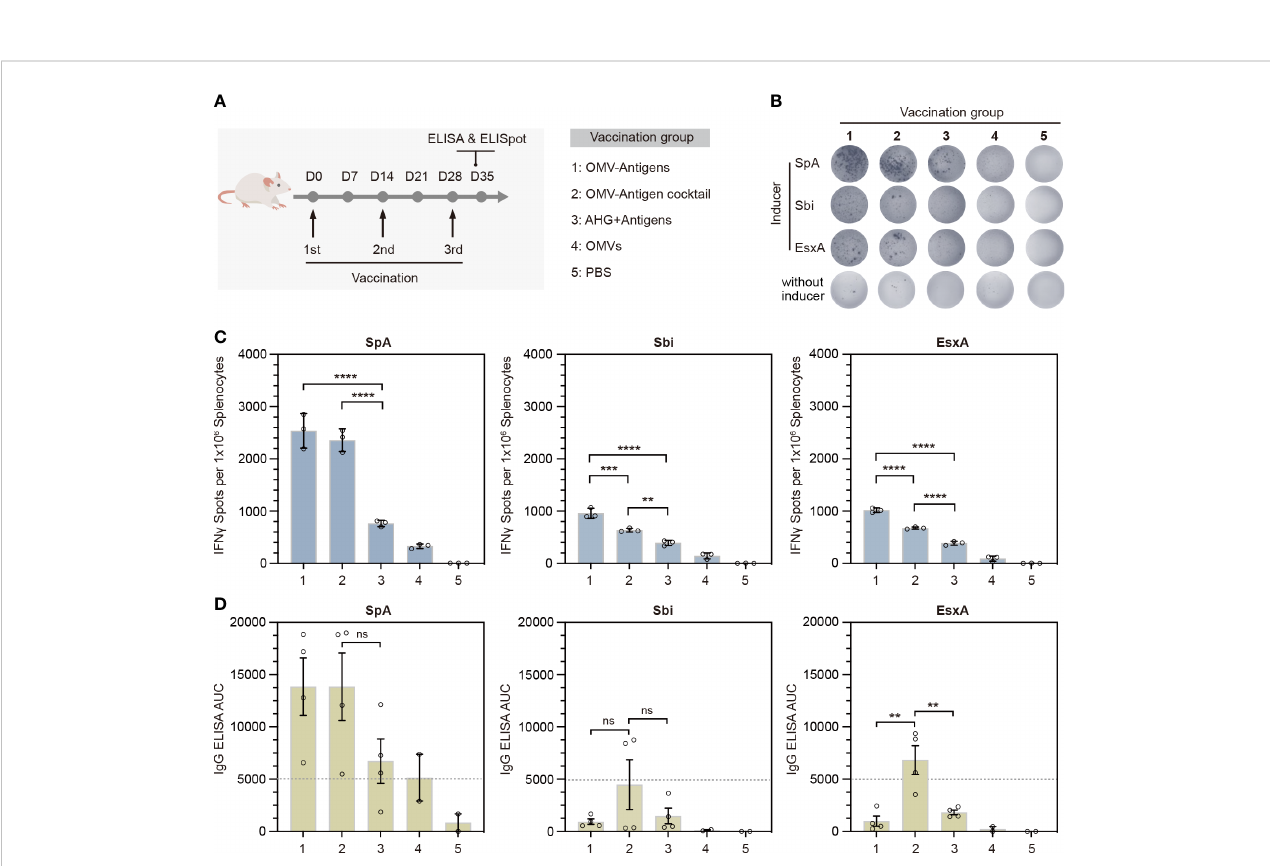
FIGURE 4 In vivo immunogenicity test of the OMV-based S. aureus click vaccine. (A) Schematic representation of the vaccination strategy and each vaccination group. (B) Representative images of splenic IFN- g ELISpot responses for each immunization group. (C) Quanti fi cation of IFN- g positive splenocytes for each immunization group. Splenocytes were prepared from spleens taken from mice (n=3) 7 days post the third immunization. (D) Quanti fi cation of antigen-speci fi c IgG for each immunization group by ELISA in terms of the area under the curve (AUC). Sera were taken from mice (n=4) for OMV-Antigens, OMV-Antigen cocktail and AHG +Antigens immunization groups and mice (n=2) from OMV and PBS immunization group 7 days post the third immunization. The data are shown as mean ± SEM. Statistical analysis was performed by one way ANOVA. ns, not signi fi cant. ** P < 0.01; *** P < 0.001; **** P <